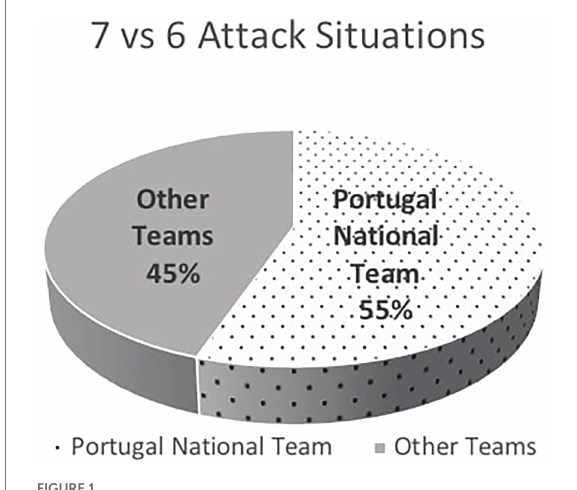
FIGURE 1 7 vs. 6 attack situations (empty